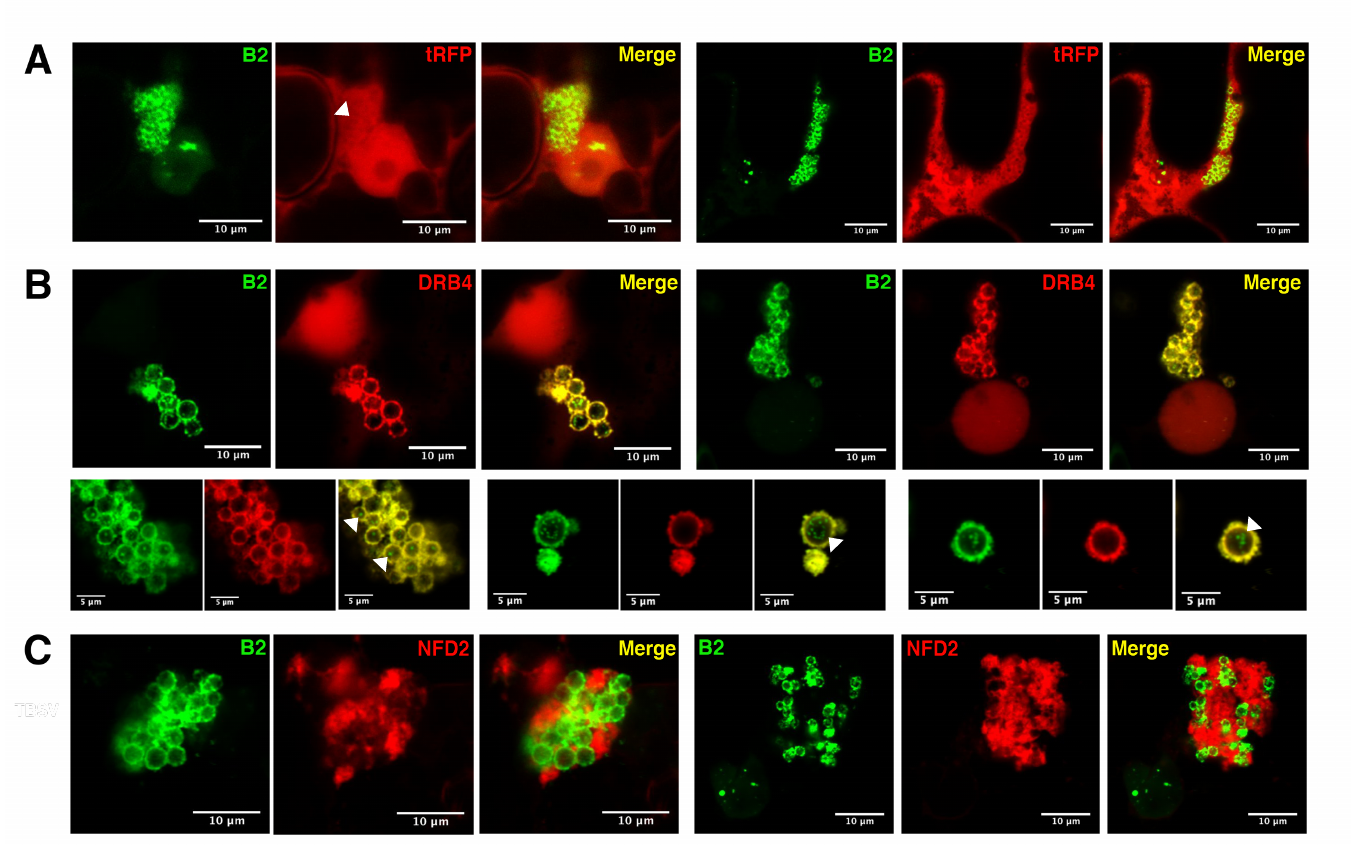
Figure 4. Localization of A. thaliana DRB4 to TBSV replication complexes. Laser confocal microscopy on 35S: B2:GFP / N. benthamiana leaves inoculated with A. tumefaciens carrying the construct of interest then infected with TBSV. For each acquisition we show the GFP channel on the left (B2), the tRFP channel in the middle (construct of interest) and a merge of the two on the right. ( A ) Observation of tissues expressing 35S: tRFP . ( B ) Observation of tissues expressing 35S: DRB4:tRFP . The lower row of three acquisitions is shown to highlight the intraperoxisomal B2 foci (white arrowheads). For the sake of simplicity, the labeling was omitted on these but is identical to that in the upper row. ( C ) Observation of tissues expressing 35S: tRFP:NFD2 . All acquisitions were performed with a 63 × objective. Scale bars indicate 5–10 µ m, as indicated. Lower magnification acquisitions from these tissues, along with the respective non-infected controls, can be found in Supplementary Figure